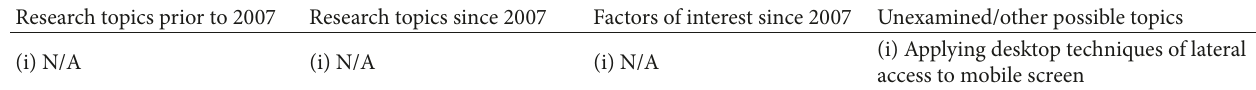
Table 8: Lateral access research.